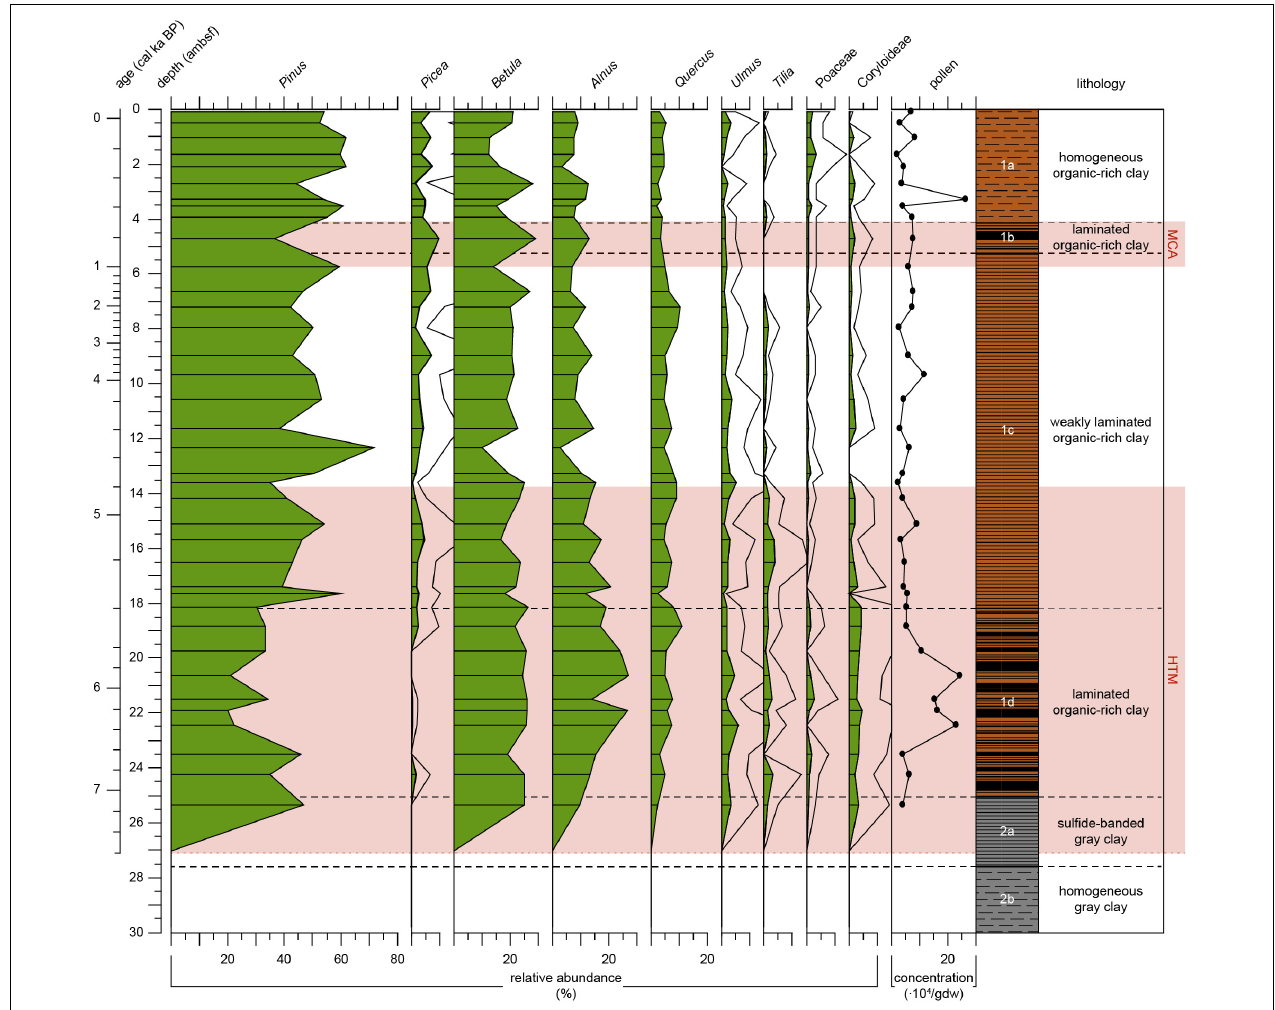
FIGURE 6 | Pollen record of Integrated Ocean Drilling Program Expedition 347 core M0063D plotted versus depth (adjusted meters below seafloor). Relative abundance of selected pollen taxa (%) indicated by green-filled areas, abundances of pollen taxa that have a relative abundance < 10% are in addition 4x exaggerated (black line). Carpinus and Corylus (hornbeam and hazel) are combined in the group Coryloideae. Analyzed levels are indicated by the black lines. Pollen concentrations in x 10 4 /gram dry weight. The warm climate anomalies Holocene Thermal Maximum (HTM, 8–4.8 cal ka BP, Seppä et al., 2009) and Medieval Climate Anomaly [MCA, 1.0 – 0.7 cal ka BP(MCA, 1.0 – 0.7 cal ka BP, Mann et al., 2009)] are represented by the light red areas. Lithology and sedimentological units are obtained from Andrén et al.